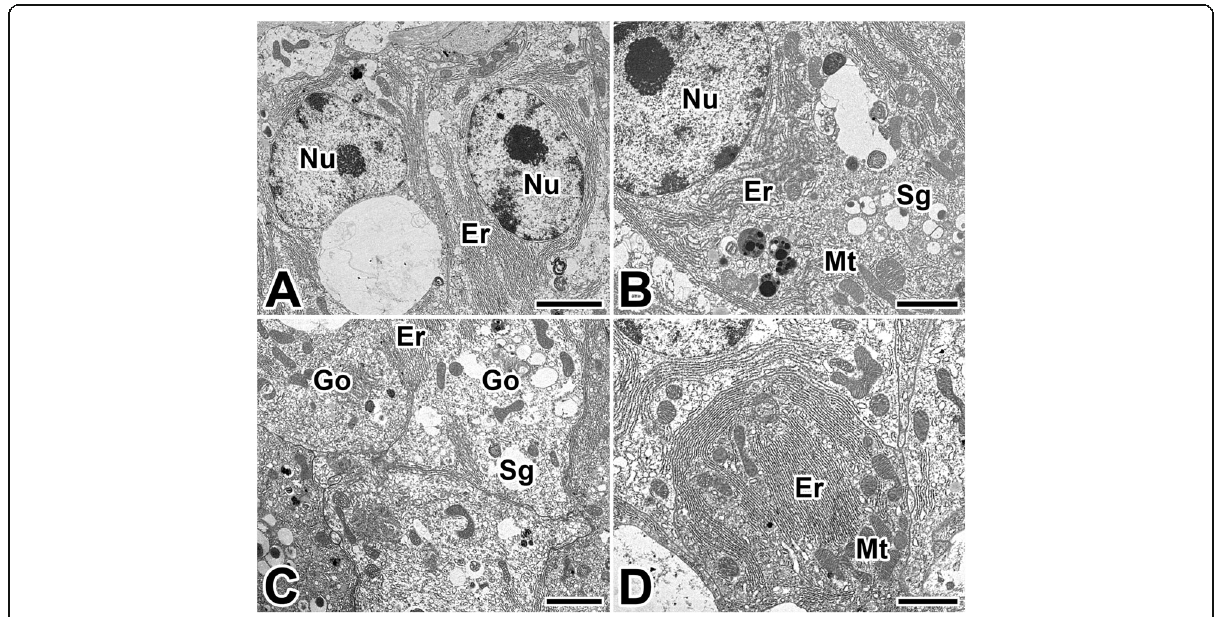
Fig. 6 Transmission electron micrographs of the posterior silk gland in the caddisworm H. nigrovittatus. a Glandular epithelial cells have a large nucleus (Nu) with a prominent nucleolus. b - d At the vicinity of secretory granules (Sg), large amount of rough endoplasmic reticulum (Er), mitochondria (Mt), and Golgi apparatus (Go) are seen. Scale bars indicate 5 μ m ( a ), 2 μ m ( b ), and 1 μ m ( c , d ), respectively